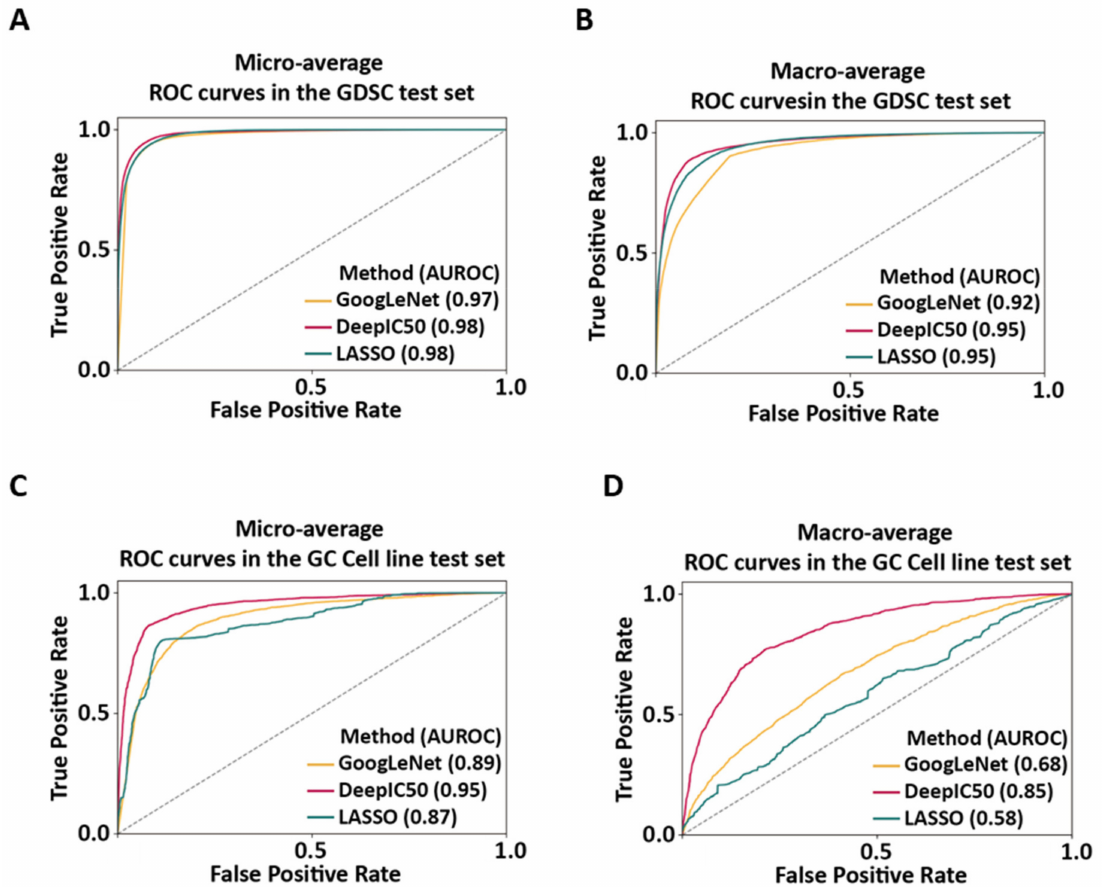
Figure 4. Comparison of GoogLeNet and DeepIC50 along with the baseline LASSO model. The prediction performances of the two CNN models and LASSO were compared by drawing micro-/macro-average ROC curves. ( A ) The micro-average AUROCs in the GDSC test set. ( B ) The macro-average AUROCs in the GDSC test set. ( C ) The micro-average AUROCs in the GC cell line test set. ( D ) The macro-average AUROCs in the GC cell line test